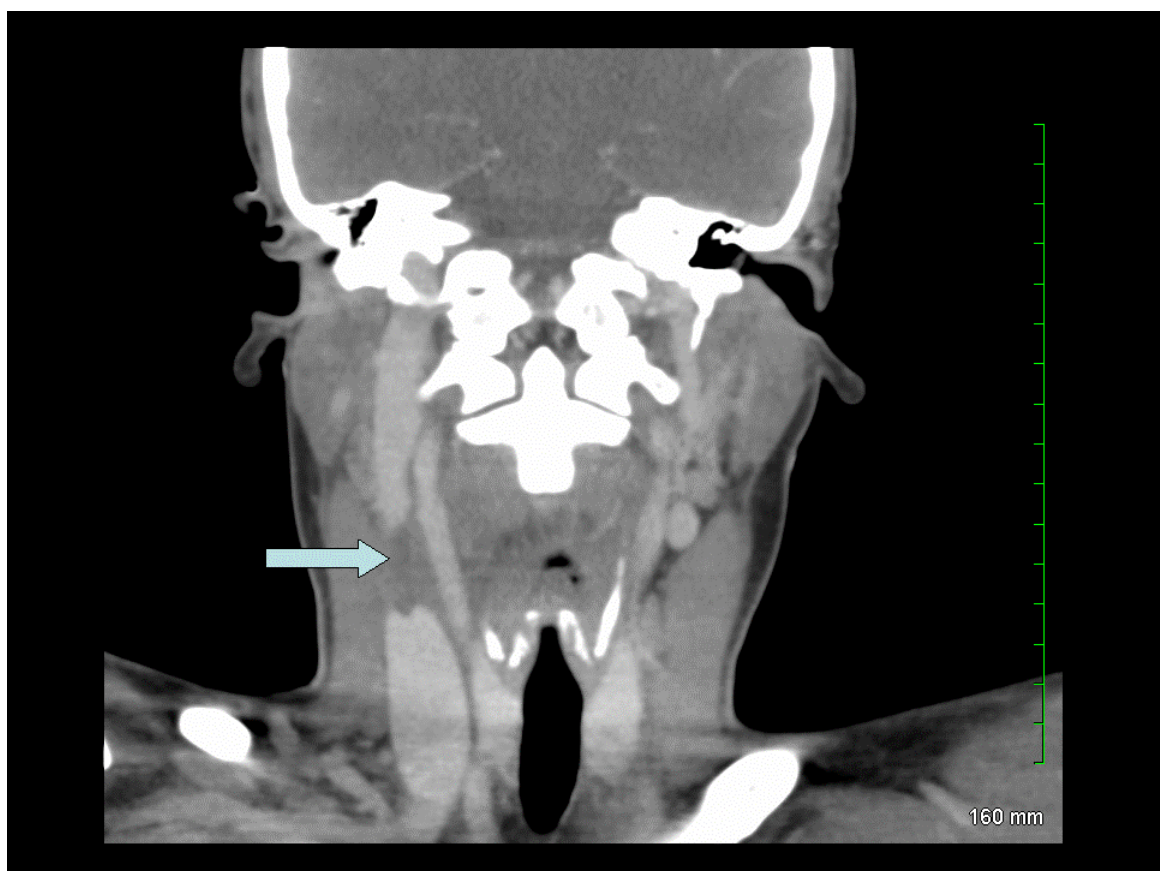
FIGURE. CT of the neck with contrast: nonocclusive soft tissue filling defect extending over 2 cm is consistent with a thrombus seen within the right internal jugular vein at the level of the hyoid bone